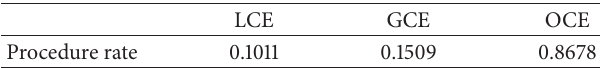
Table 6: CE error detection results of our proposed system. LCE GCE OCE Procedure